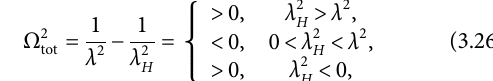
FIGURE 4 | The potential terms Ω 2 and Ω 2 eff are compared with the curvature term a ’’ / a in mLQC-I near the bounceand the prein fl ationary regime for the quadratic potential V ( ϕ ) (cid:2) 1 m 2 ϕ 2 (Li et al., 2